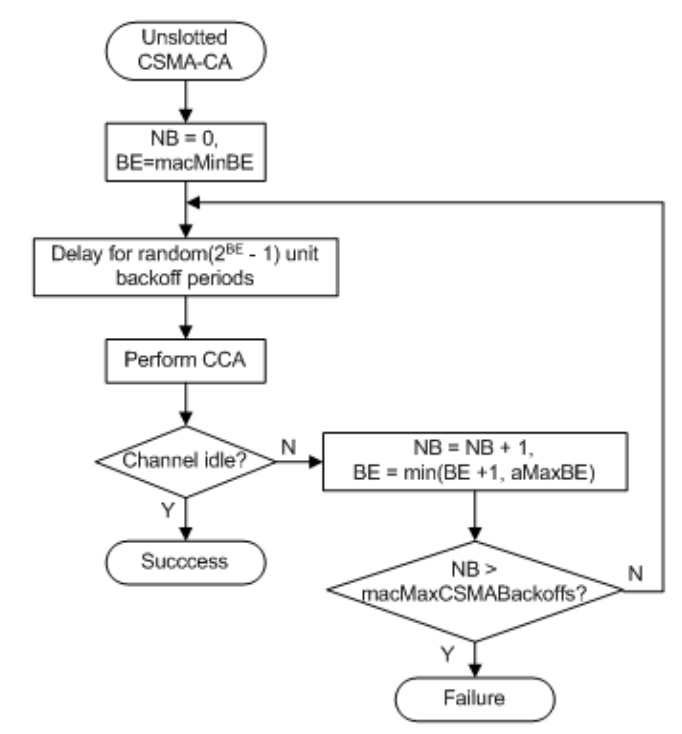
Figure 1. Unslotted CSMA/CA algorithm.